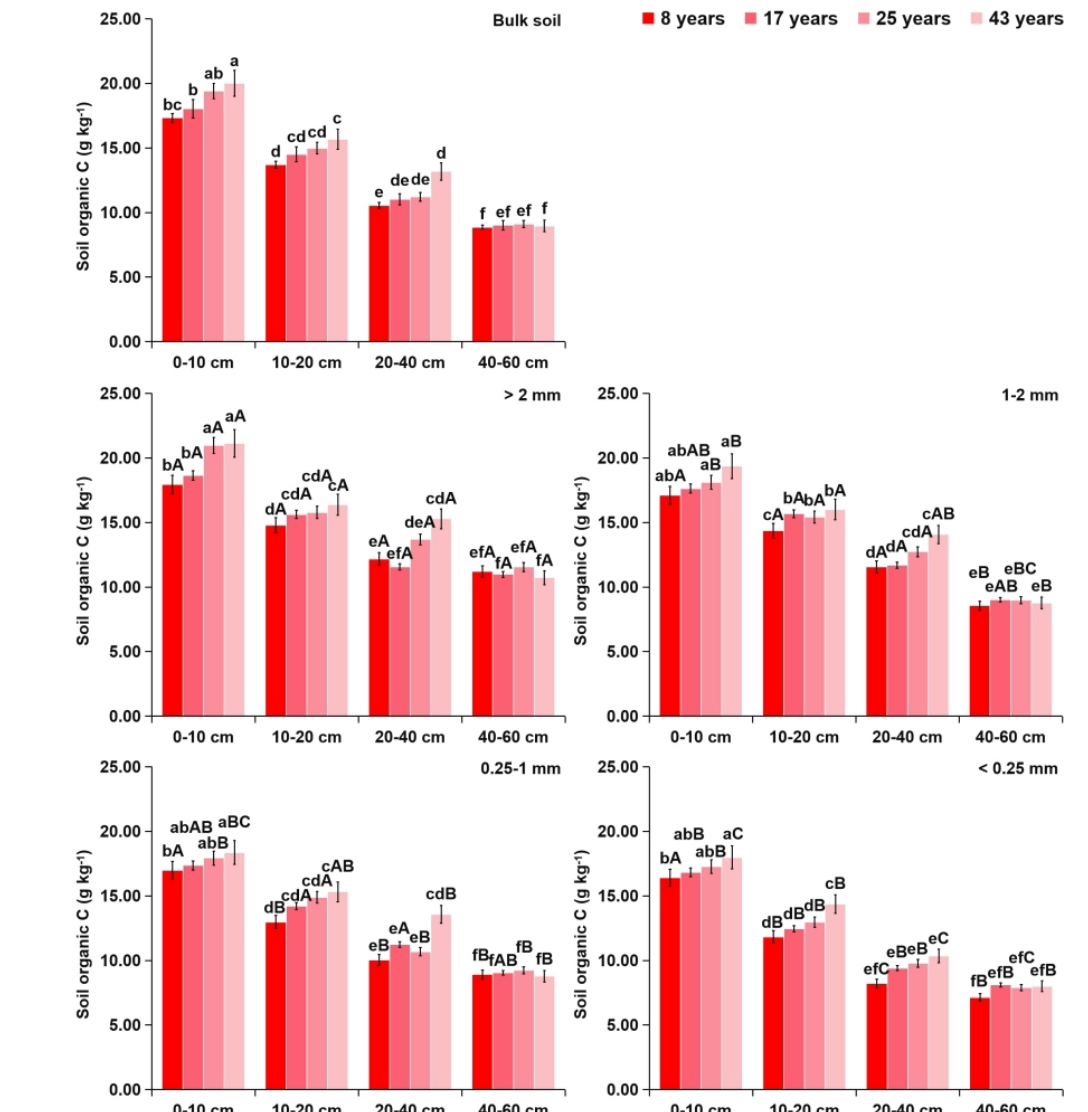
Figure 2. Effects of soil depth and tea plantation age on the organic C content in bulk soil and different-sized aggregates. Data represent the mean of five replicates and error bars represent the standard deviations. Means with the same lowercase letter are not significantly different ( p > 0 . 05) among different soil depths and tea plantation ages. Means with the same capital letter are not significantly different ( p > 0 . 05) among different-sized